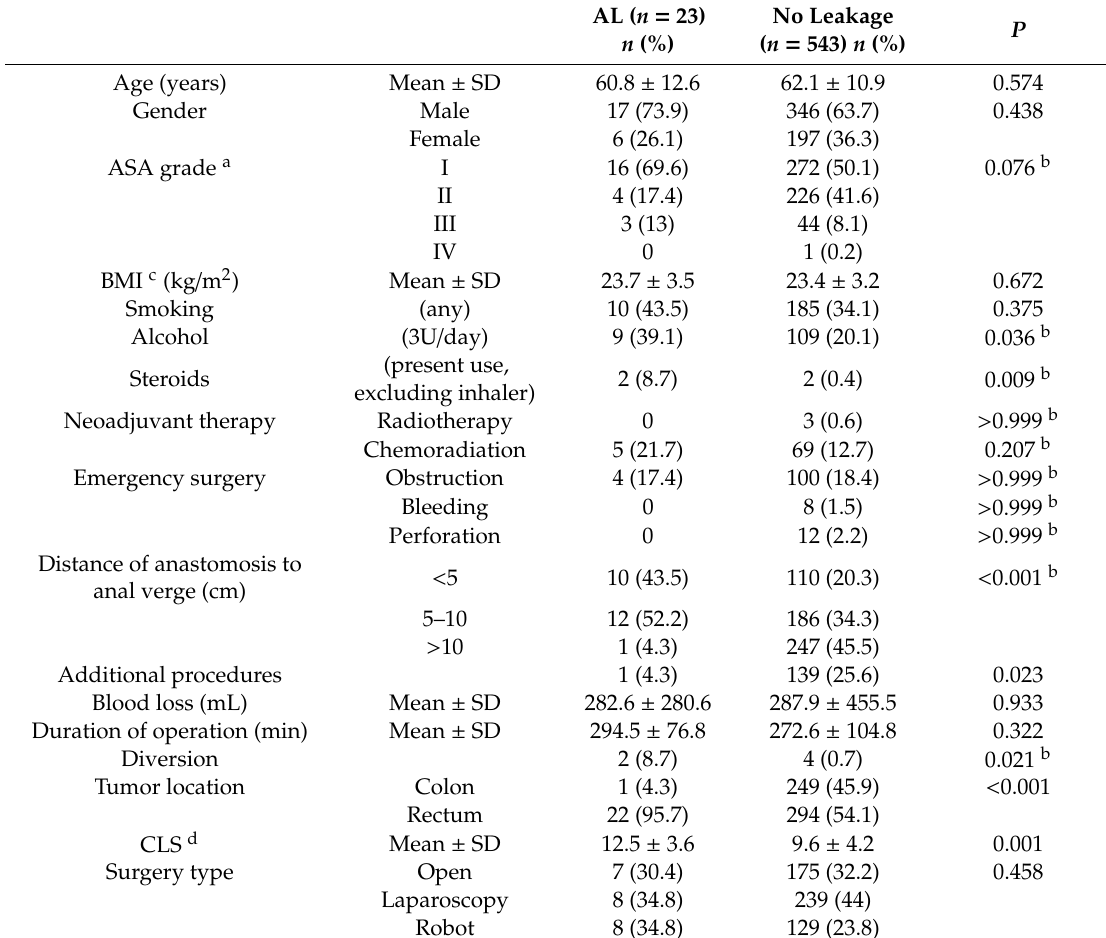
Table 1. Comparison of patient characteristics between AL group and No leakage group.